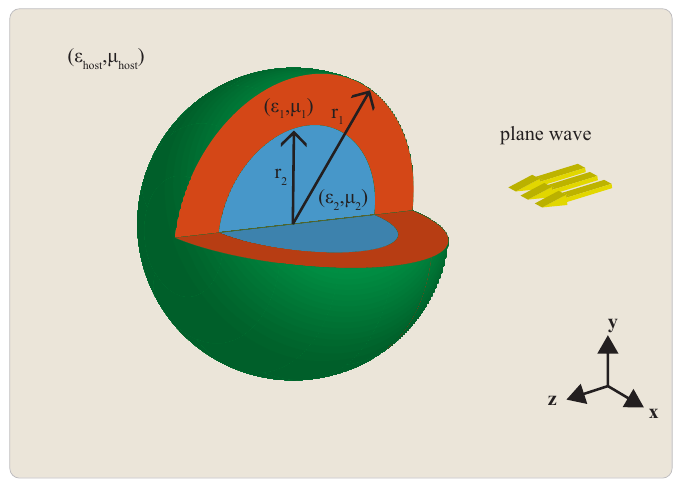
Figure 5. Schematic representation of a core–shell sphere subject to a electrostatic field embedded in a host medium. Region 1 represents the shell region, while region 2 represents the core. η = 0.1